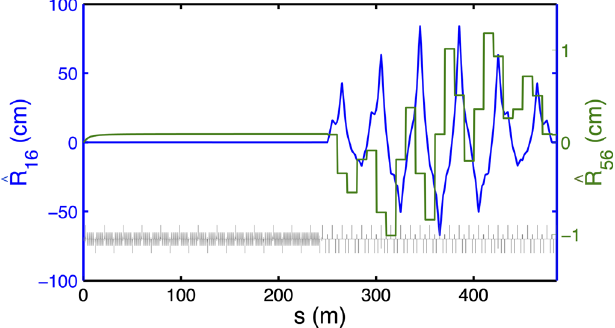
FIG. 4. Dispersion (blue) and momentum compaction (green) functions of the example linac-arc lattice.